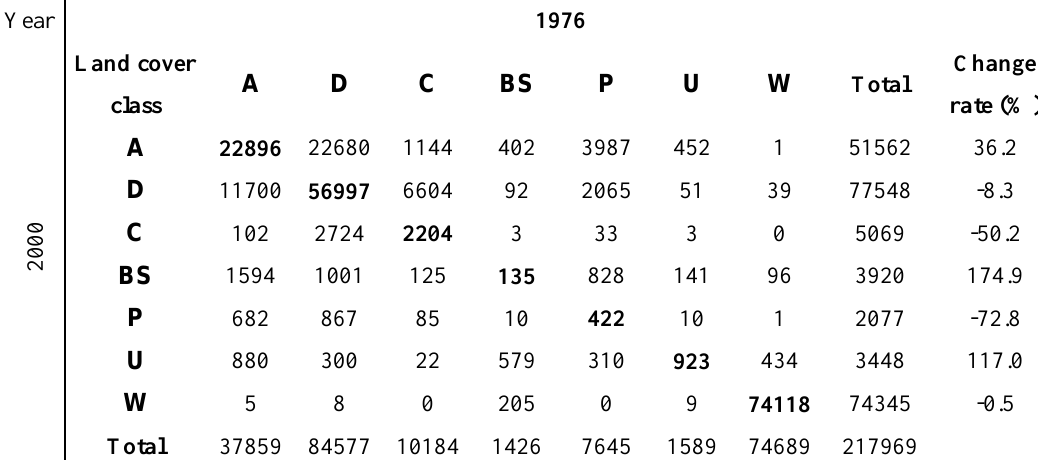
Table 4. Change matrix of land use land cover (ha) in 1976 to